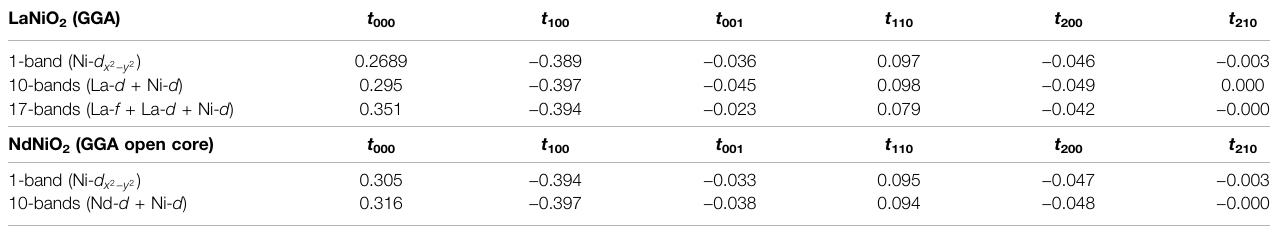
TABLE 3 | Major hopping elements (in units of eV) of the Ni-3 d x 2 − y 2 orbital from 1-band (Ni-3 d x 2 − y 2 ), 10-bands (La/Nd- d + Ni- d ), and 17-bands (La/Nd- f + La/Nd- d + Ni- d ) Wannier projections. The DFT-relaxed lattice parameters are as follows: LaNiO 2 ( a (cid:2) b (cid:2) 3.88 Å, c (cid:2) 3.35 Å), NdNiO 2 ( a (cid:2) b (cid:2) 3.86 Å, c (cid:2) 3.24 Å) [33].